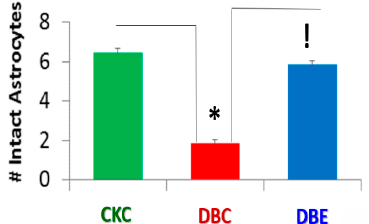
Figure 1. The diabetic db / db models have a significant decrease in the number of intact and attached astrocyte foot processes (ACfp) at the outer basement membrane of the capillary neurovascular unit (NVU): This image represents the mean number (#) of astrocytes (ACfp)/NVU that are firmly attached and abut to the outer endothelial and pericyte outer basement membranes of the capillary neurovascular unit (NVU), numbering 22 in CKC (control heterozygous: green), 25 in DBC (diabetic db/db : red), and 22 in db / db empagliflozin-treated (DBE: blue) for a total of 69 capillary NVUs counted. The mean number of ACfp/NVU was 6.4 ± 1.1 in CKC, 1.88 ± 0.72 in diabetic DBC, and 5.86 ± 0.88 in diabetic db / db treated with the SGLT2 inhibitor (empagliflozin) DBE. * CKC compared to DBC ( p -value < 0.05); ! DBC compared to DBE ( p -value < 0.05).